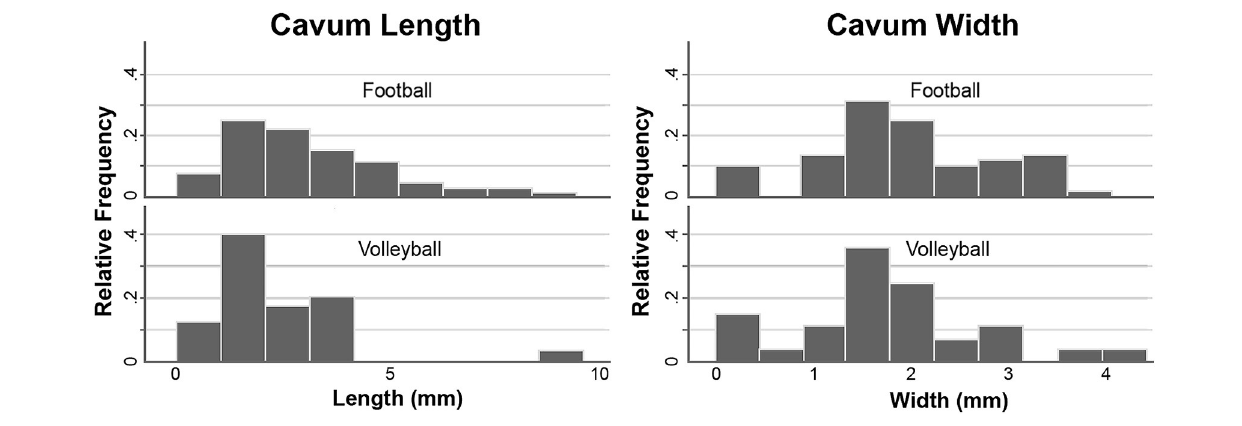
FIGURE 2 | Histograms showing that the cavum length is greater in football compared to volleyball (left), while the cavum width is similar